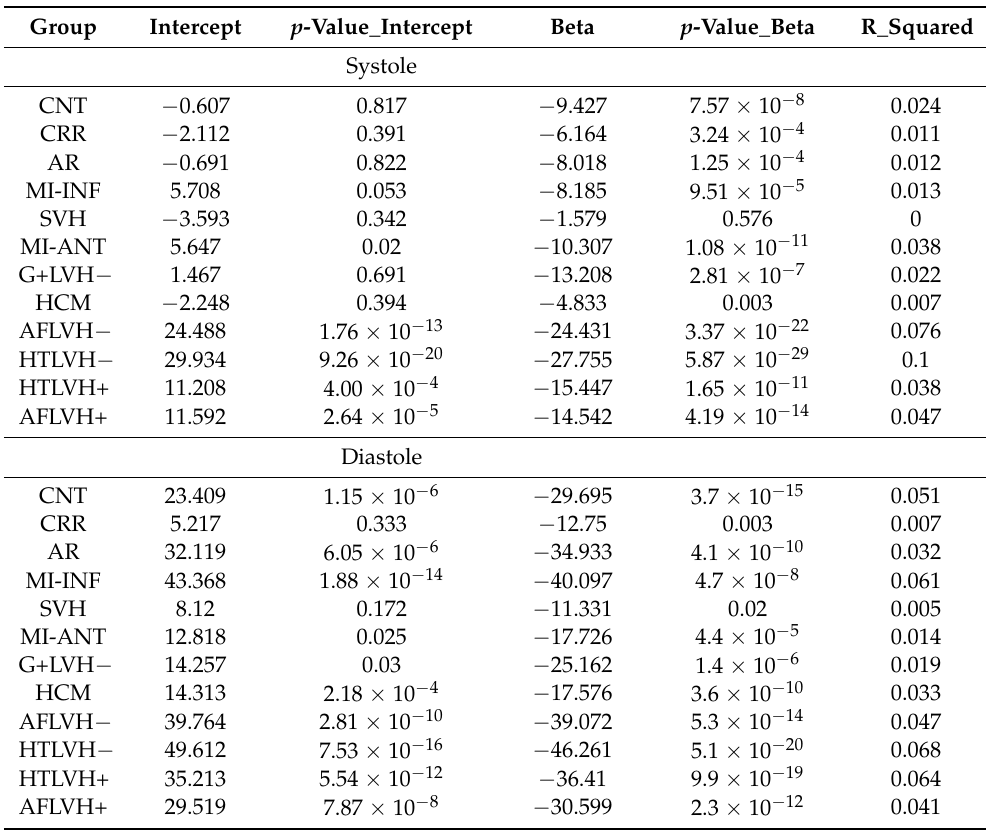
lines with confidence intervals. Points are colored according to their affiliation to “parallels” in the context of LV topology shown in Figure 2: cyan at the base, yellow-green in the middle, red in the apex. The vertical lines at x = 1 and the horizontal one y = 0 indicate the upper and lower limits (respectively) within which we expect to see the ranges of these variables. CNT behave consistently with this expectation (i.e., Endo/Epi RMS curvature ratio always >1 and α p differences always <1). The other categories do the same with a few exceptions. Table 3. Details of per-group regressions between Endo/Epi RMS curvature ratio vs. α p differences (per category and per-landmark median values). Results for systole and diastole are shown. Group Intercept p -Value_Intercept